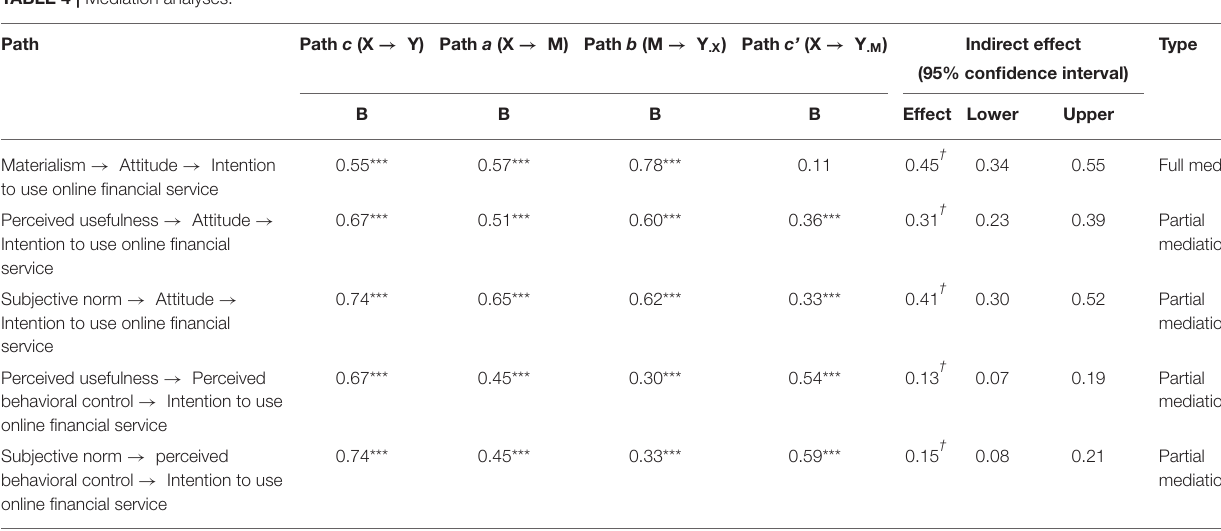
TABLE 4 | Mediation